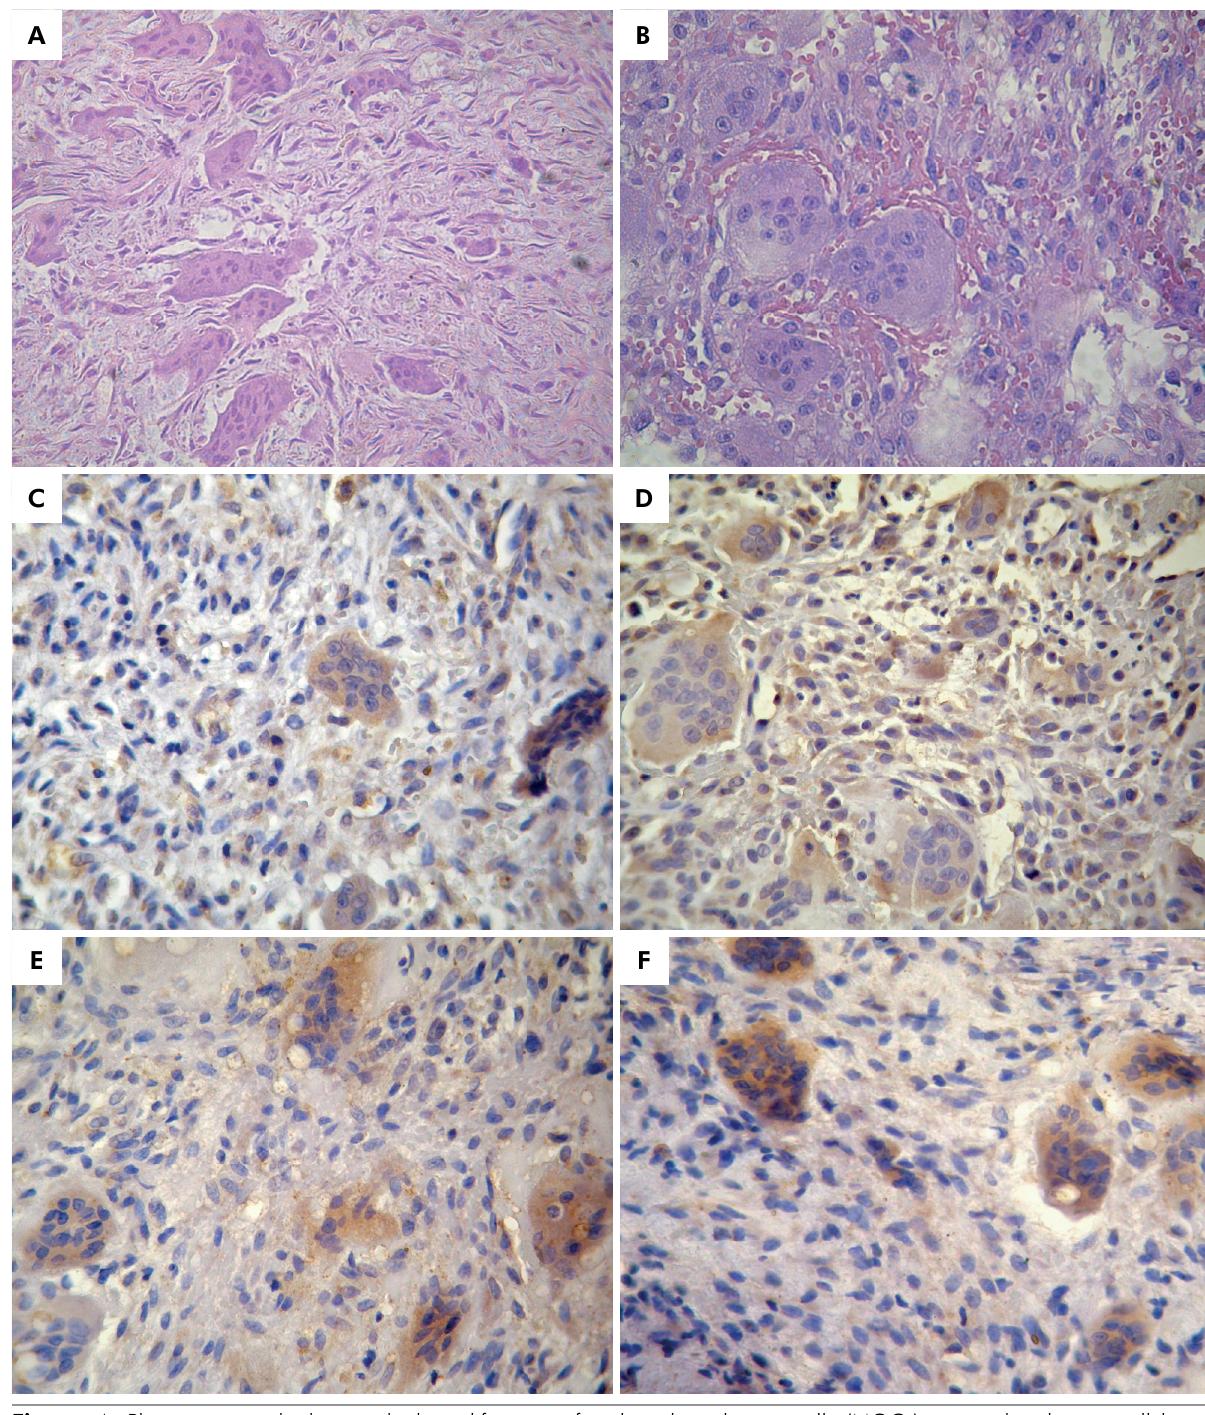
Figure. A. Photomicrograph showing high proliferation of multinucleated giant cells (MGCs) in peripheral giant cell lesion (Haematoxylin and eosin, original magnification 400x); B: Photomicrograph showing high proliferation of multinucleated giant cells (MGCs) in central giant cell lesion (Haematoxylin and eosin, original magnification 400x); C: Immunohistochemical expression of RANKL in MGCs and in mononuclear cells of peripheral giant cell lesion (Original magnification 400x); D: Immunohistochemical expression of RANKL in MGCs and in mononuclear cells of central giant cell lesion (Original magnification 400x); E: Immunohistochemical expression of osteoprotegerin in MGCs and in mononuclear cells of peripheral giant cell lesion (Original magnification 400x); F: Immunohistochemical expression of osteoprotegerin in MGCs and in mononuclear cells of central giant cell lesion (Original magnification 400x).